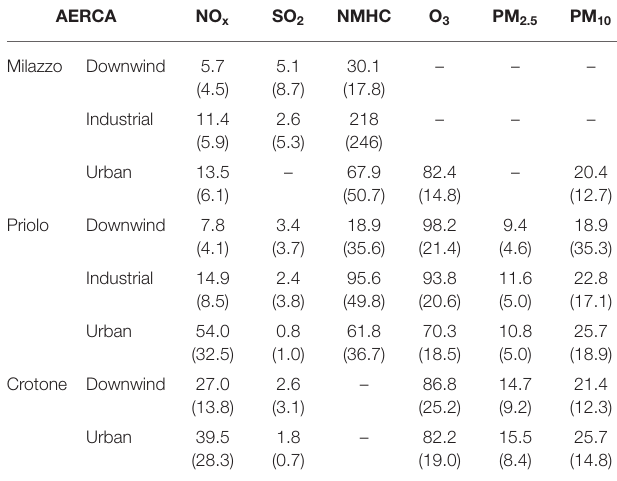
TABLE 2 | Averaged concentration of investigated gas-phase species over the entire study period in µ g/m 3 (standard deviation is indicated in brackets) (January 2016–December